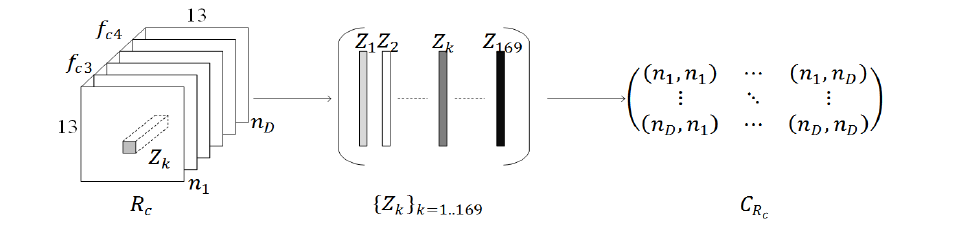
Figure 2. R c and fusion process of different feature points.